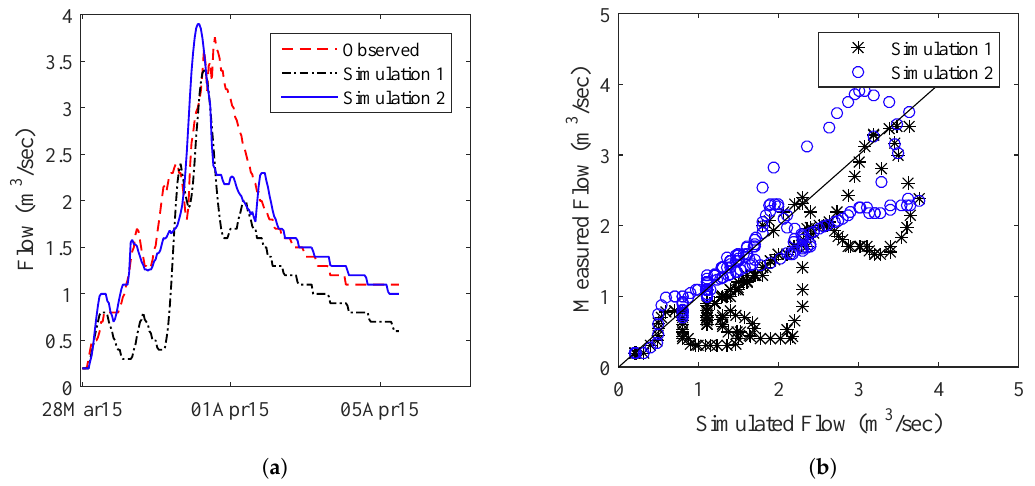
Figure 6. Event modelling of hourly flow series on an event of 28 March 2015 (12:00) to 6 April 2015 (12:00) for the Sturgeon Creek Watershed. Simulation 1 utilizes one soil moisture value from the Fall Soil Moisture Survey, while Simulation 2 utilizes initial soil moisture values from RADARSAT-2. ( a ) Comparison of the observed and simulated hydrograph; ( b ) the distribution of points is shown from the y = x